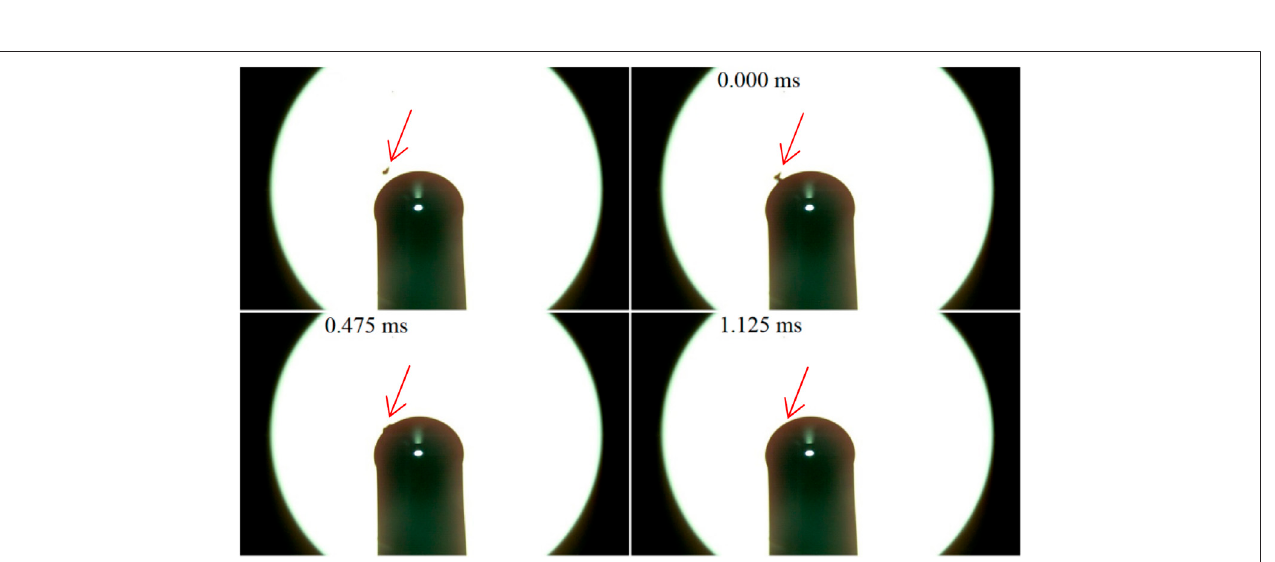
FIGURE 10 | Blasting demolition dust and surfactant solution droplets collision